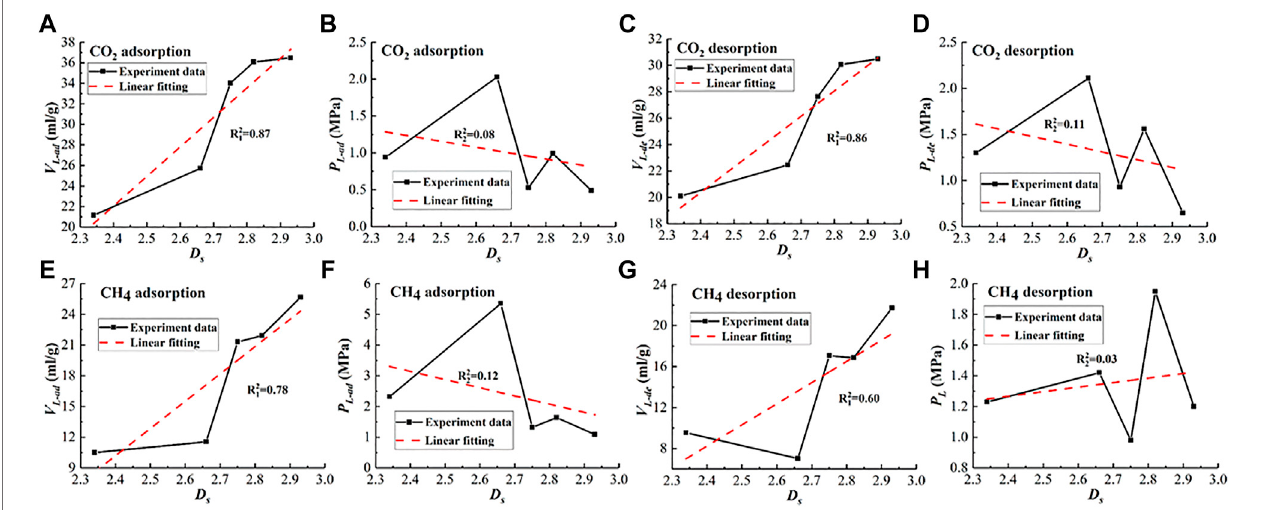
FIGURE4| Relationshipbetween D s andLangmuirconstants. (A) D s vs. V L-ad forCO 2 , (B) D s vs. P L-ad forCO 2 , (C) D s vs. V L-de forCO 2 , (D) D s vs. P L-de forCO 2 , (E) D s vs. V L-ad for CH 4 , (F) D s vs. P L-ad for CH 4 , (G) D s vs. V L-de for CH 4 , and (H) D s vs. P L-de for CH 4